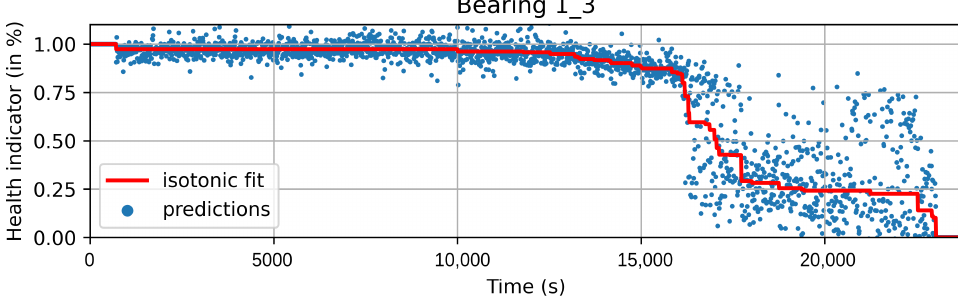
Figure 6. Model predictions and best isotonic fit after 20 iterations of the HI algorithm. Highlighted in red is the last fit of the isotonic, which is used for the generalized